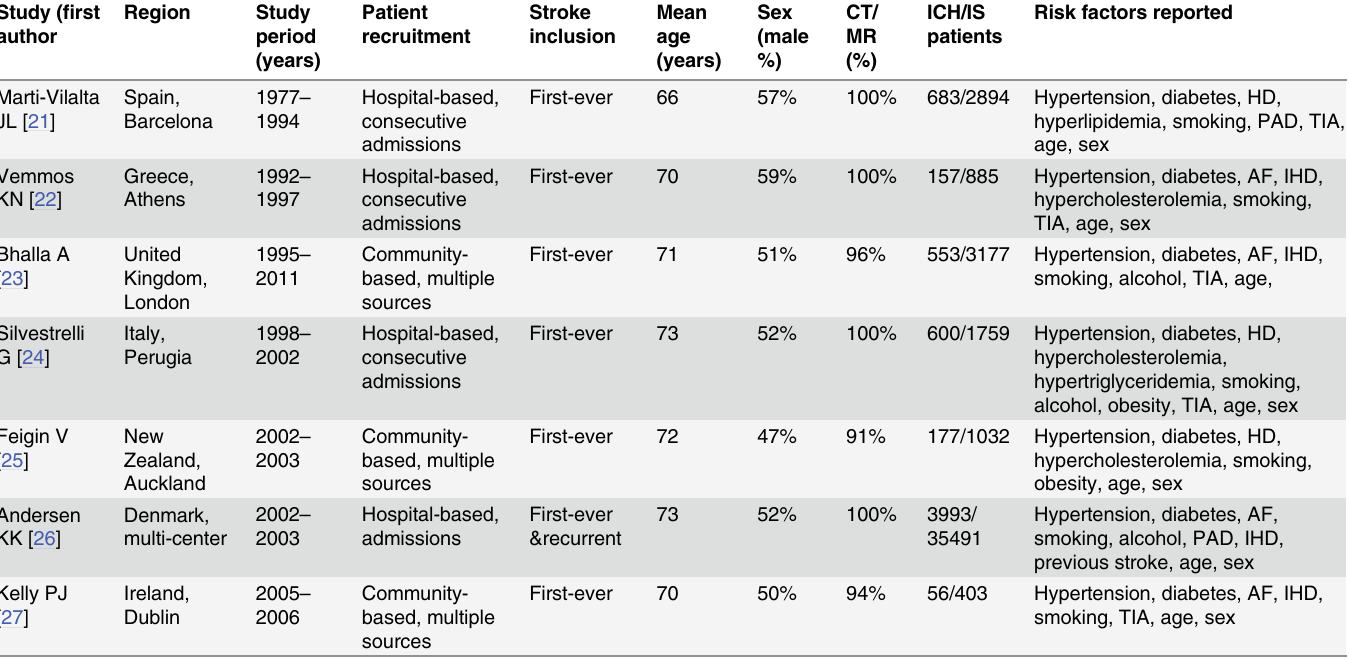
Table 2. Clinical characteristics of included studies in white populations.